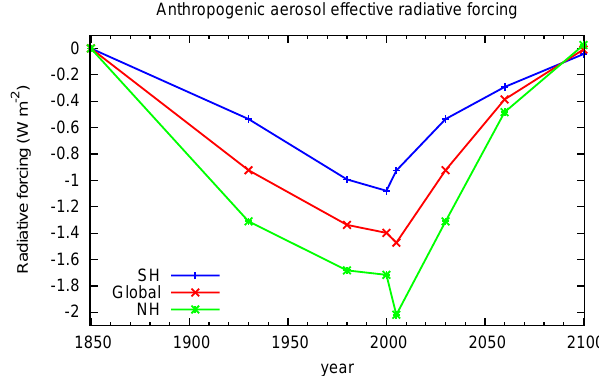
Fig. 3. Anthropogenic aerosol effective radiative forcing for the his- torical period and RCP4.5, averaged over the SH (blue line), the globe (red line) and the NH (green line). Calculations are for years 1850, 1930, 1980, 2000, 2005, 2030, 2060 and 2100, with linear interpolation in